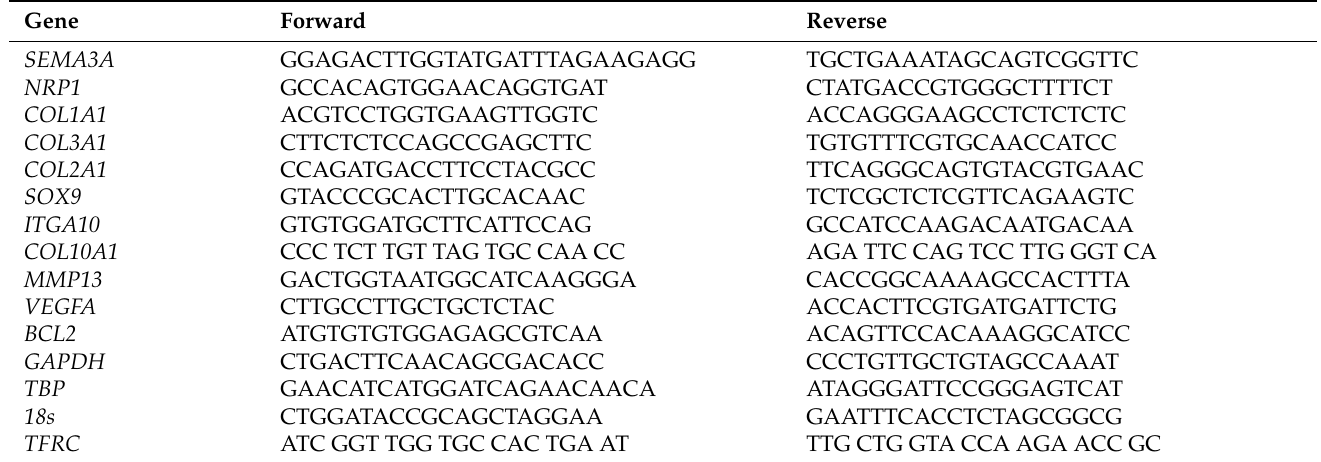
Table 1. Primer sequences used in this